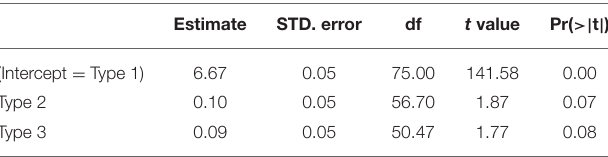
TABLE 7 | Linear regression analysis of the response latencies of the reaction times to incorrectly accepted nonces in experiment 1.